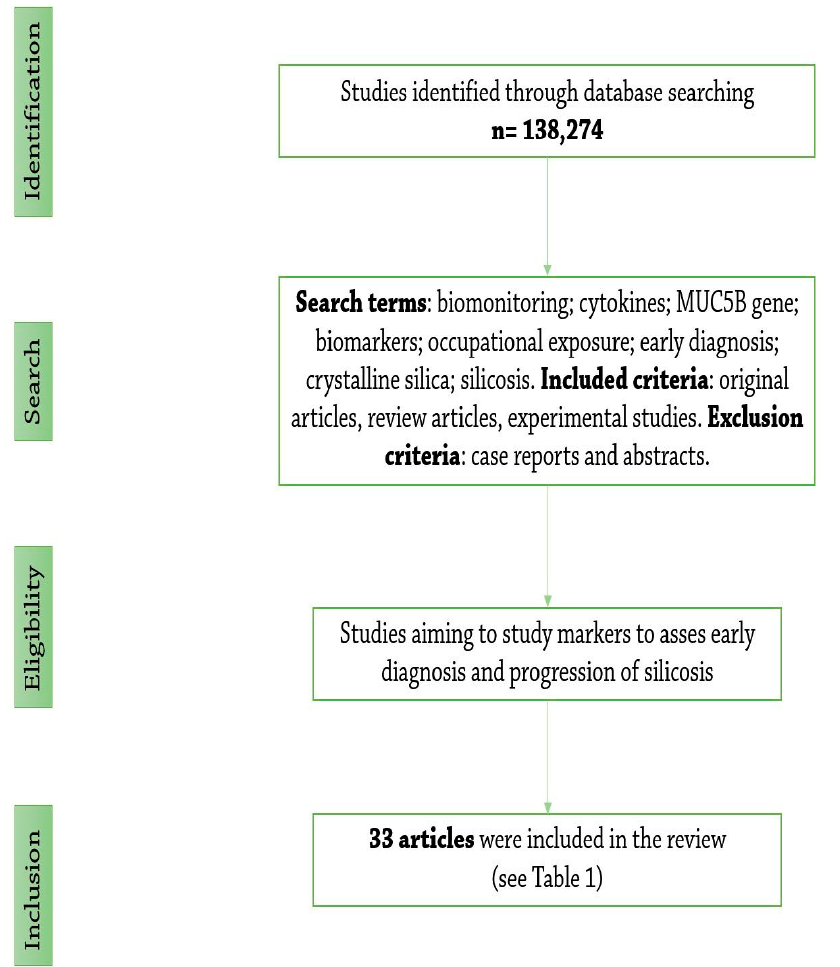
Figure 1. Flowchart of the literature search.